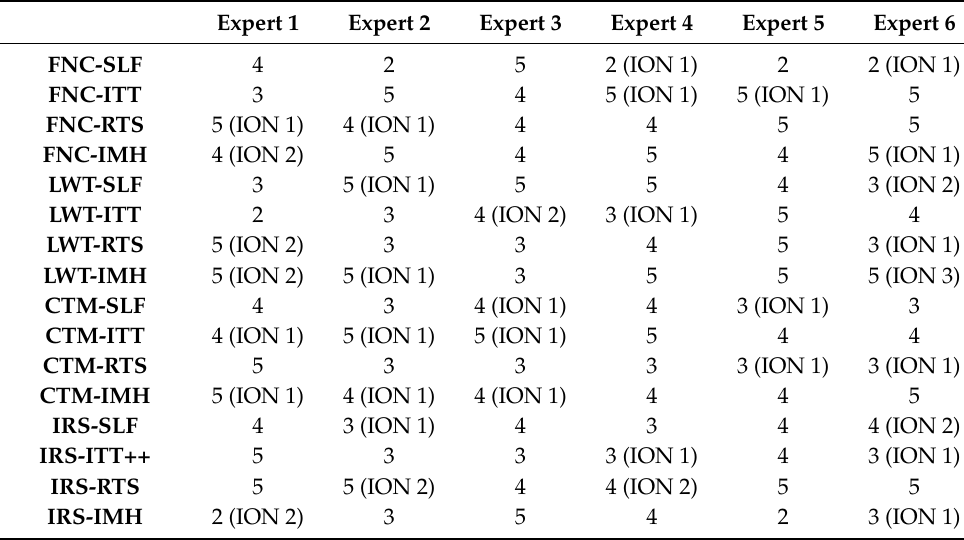
Table A7. Completed expert evaluations for the competencies.